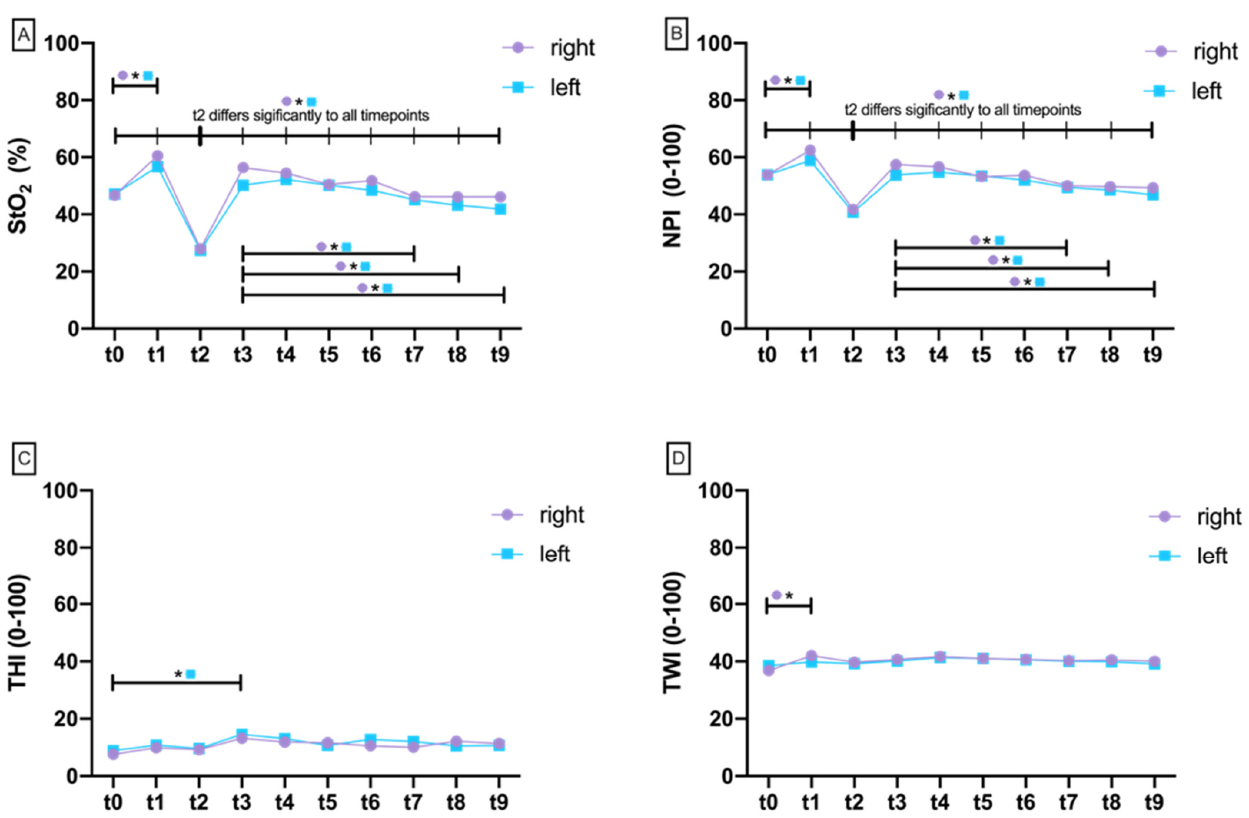
Figure 4. Aligned dotplot show hyperspectral parameters at different measurement timepoints (t0–t9) as mean values. ( A ) Tissue oxygenation saturation (StO 2 ), ( B ) near-infrared perfusion index (NPI), ( C ) tissue hemoglobin index (THI), and ( D ) tissue water index (TWI). Crossbars with asterisks mark significant differences.